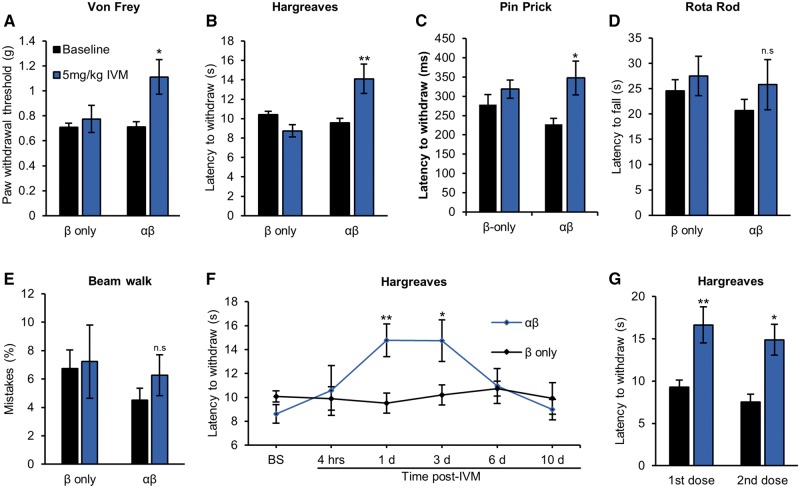

GluCl activation increases thermal and mechanical pain thresholds. (A) Von Frey test of mechanical sensitivity (β only, n = 14 animals and αβ, n = 13); (B) Hargreaves test of thermal sensitivity (β only, n = 14 animals and αβ, n = 13); (C) Pinprick assay of noxious mechanosensation (β only, n = 11 animals and αβ, n = 10); (D) Rotarod test of motor performance (β only, n = 14 animals and αβ, n = 13); and (E) beam walk test of proprioception (β only, n = 8 animals and αβ, n = 9) of GluCl AAV animals before and 24 h following 5 mg/kg ivermectin (IVM). Student’s paired t-test. (F) Time course of thermal sensitivity following a single dose of systemic ivermectin. Repeated measures ANOVA followed by post hoc Bonferroni test comparing β only (n = 12) and αβ (n = 10.) (E) Ivermectin-induced change in thermal sensitivity of two separate doses of ivermectin given 24 h prior to testing, performed 3 weeks apart. Student’s paired t-test, n = 6 animals. All averaged data represent mean ± SEM. *P < 0.05, **P < 0.01. BS = baseline.